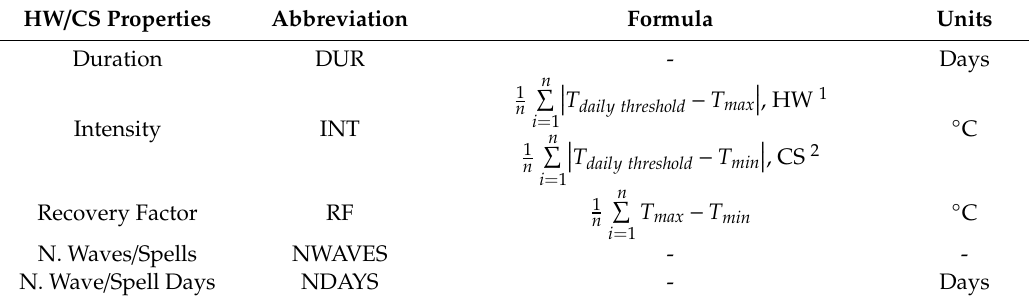
Table 1. Description of the properties of heat waves (HWs) and cold spells